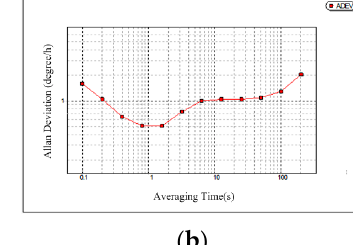
Figure 10. Spectral density of output signal. Figure 11. ( a ) linear fi tt ing of output voltages under input angular speed range of − 30°/s to 30°/s; ( b ) log-log plot of Allan deviation versus averaging time.